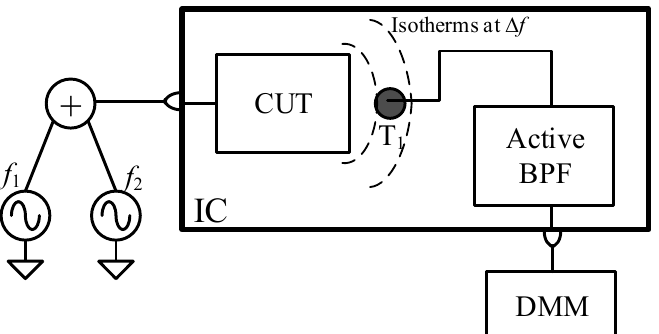
Figure 1. Circuit under test (CUT) with heterodyne driving. Temperature sensor made of a single metal -oxide semiconductor (MOS), transistor temperature transducer (T 1 ), an active Band Pass Filter (BPF), and a Digital Multimeter (DMM). Temperature variations at Δ f carry information about the CUT figures of merit at f 1 .